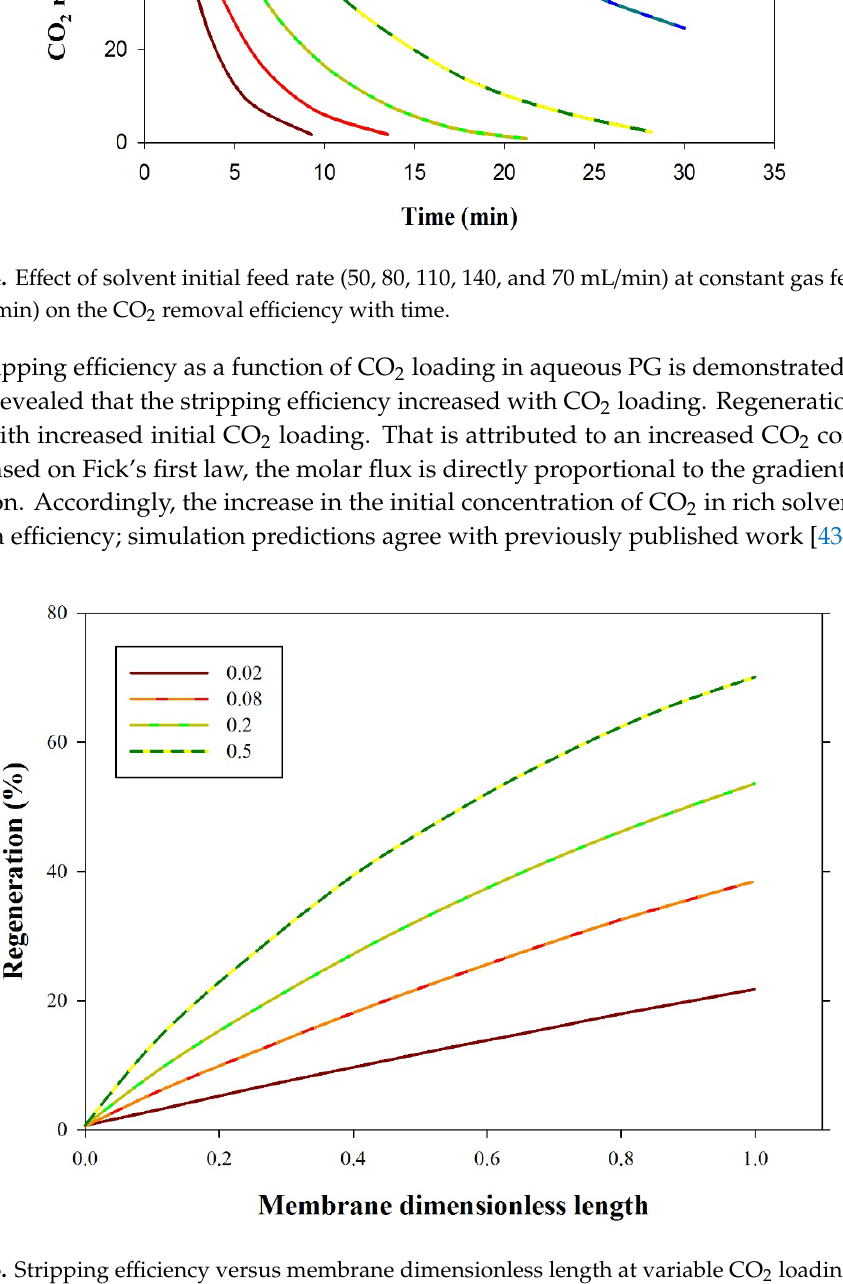
Figure 5. Stripping efficiency versus membrane dimensionless length at variable CO 2 loading in the initial solvent (0.02, 0.08, 0.2, and 0.5 mole CO 2 /mole PG), liquid flow rate = 10 mL/min, gas flow rate = 100 mL/min).